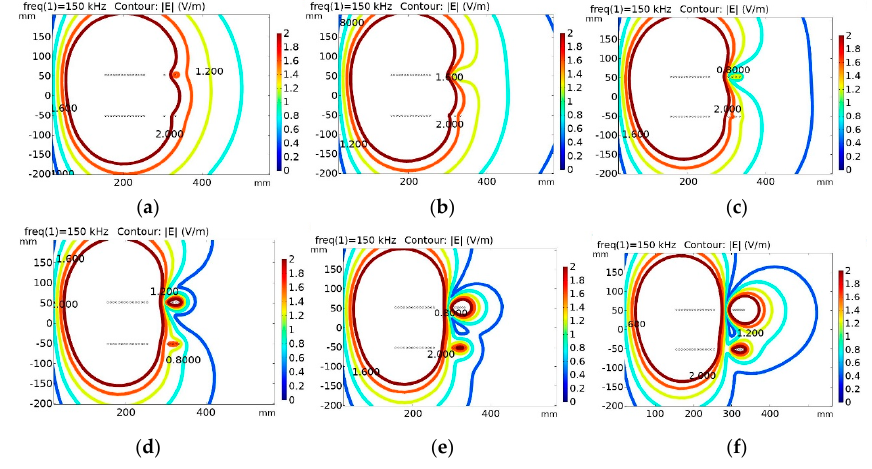
Figure 8. The power transmission e ffi ciency η and EMF distribution which are from the WPT system with series-opposing shielding coils change with the turn of shielding coils( N s ): ( a ) N p = 15, N s = 2, η = 95.43% and M η = 92.78% and M η = 89.61% and M